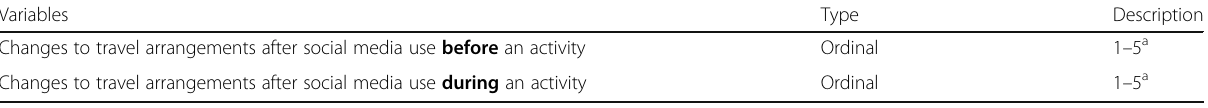
Table 2 List of tested variables about changes to travel arrangements ’ before and during an activity Variables